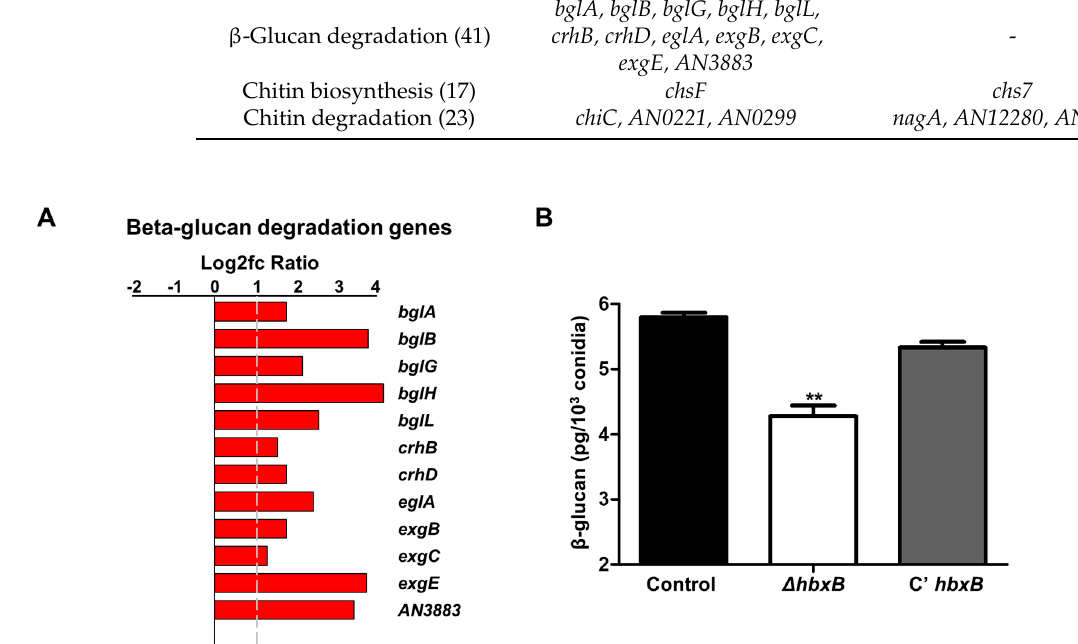
Figure 3. Role of hbxB on β -glucan degradation in A. nidulans conidia. ( A ) mRNA expression of genes associated with β -glucan degradation in hbxB deletion mutant conidia. ( B ) Amount of β -glucan in control (TNJ36), ∆ hbxB (TSH1.1), and C’ hbxB (TSH7.1) strain conidia. ** p < 0.01, differences between control and ∆ hbxB conidia.